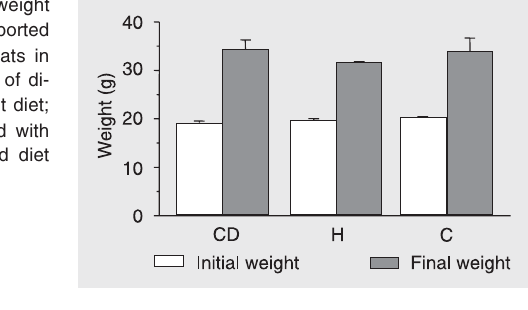
Table 2. Oxidation and phosphorylation of liver mitochondria in experimental nonalco- holic fatty liver disease. Group